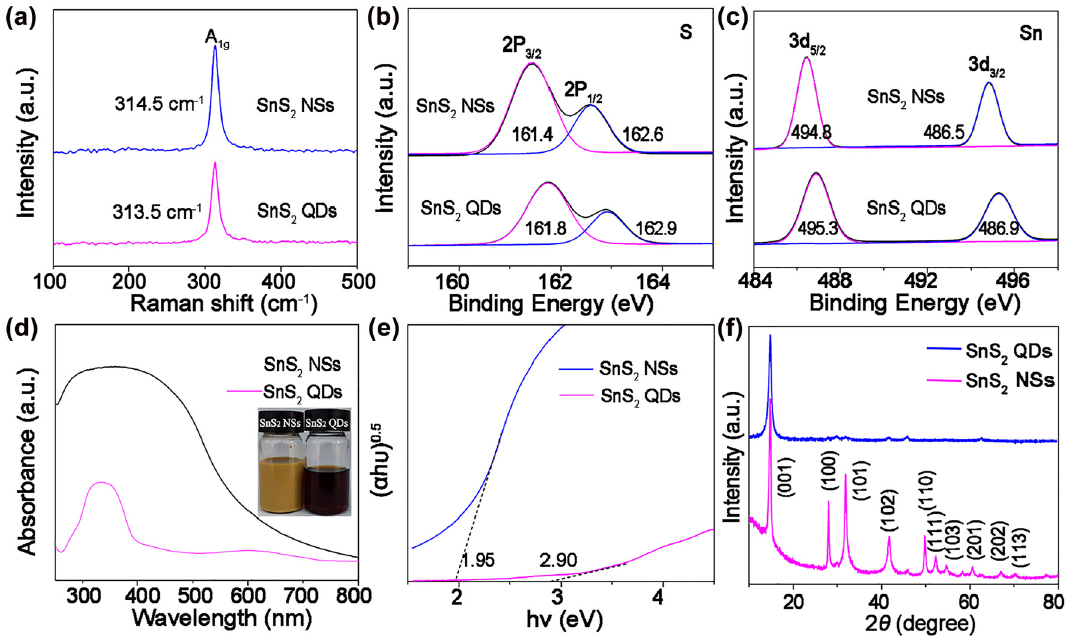
QDs. (a) Raman spectra of 2D and 0D SnS at 532 nm excitation wavelength. (b, c) XPS spectra of S 2p Figure 2: The characterization of SnS 2 2 QDs and NSs, respectively. (d) UV–visible absorption spectra. The inset shows the photographs of as-prepared SnS and Sn 3d of SnS 2 QDs solutions. (f) XRD patterns of the SnS QDs and SnS and SnS 2 2 2